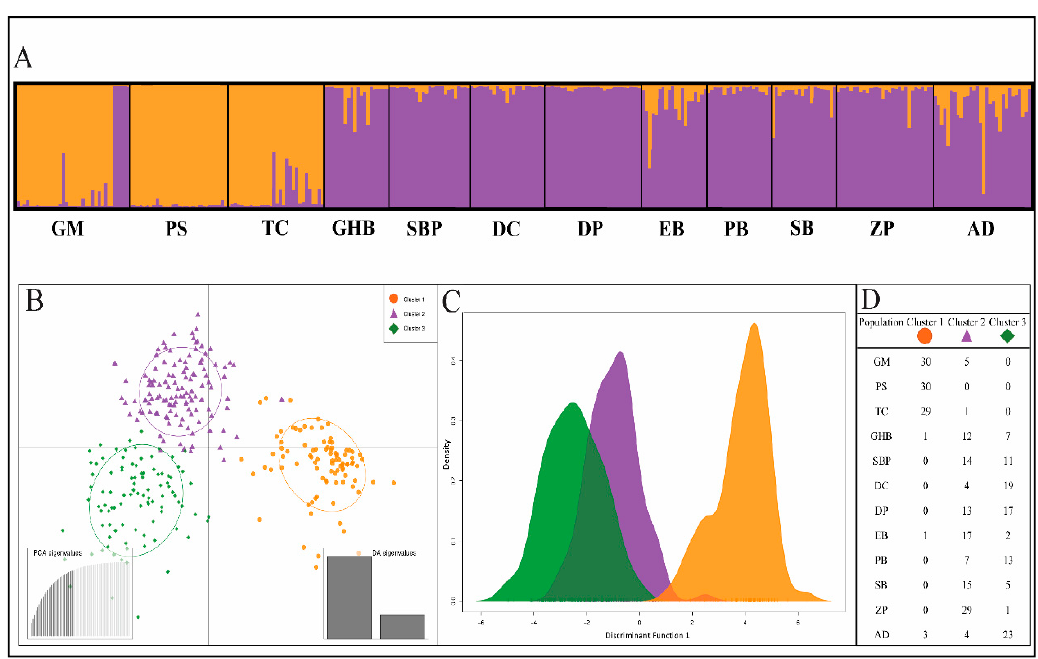
Figure 2. Identification of K clusters for G. paniculata in the MI dunes system. ( A ) Results from Bayesian cluster analysis based on nSSR data using the program STRUCTURE indicate (K = 2) population clusters. Cluster 1 (left, orange) includes the primarily northeast populations, and Cluster 2 (right, purple) includes all other populations, ( B ) Scatterplot of both discriminant function axes from the discriminant analysis of principal components (DAPC), ( C ) DAPC sample distribution on discriminant function 1, ( D ) Table of individual membership to each DAPC cluster, explained by the PCA eigenvalues used in the DAPC, based on all 69 identified principal components. Sampling location codes: Grand Marais (GM), Petoskey State Park (PS), Traverse City (TC), Good Harbor Bay (GHB), Sleeping Bear Point (SBP), Dune Climb (DC), Dune Plateau (DP), Empire Bluffs (EB), Platte Bay (PB), South Boundary (SB), Zetterberg Preserve (ZP), Arcadia Dunes (AD).